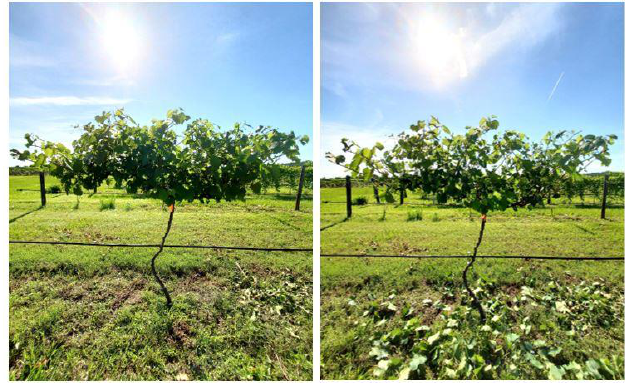
Figure 2. ‘MidSouth’ grapevine before ( left ) and after ( right ) cluster zone leaf removal of 3 to 6 leaves in McNeill, MS (May 2021).